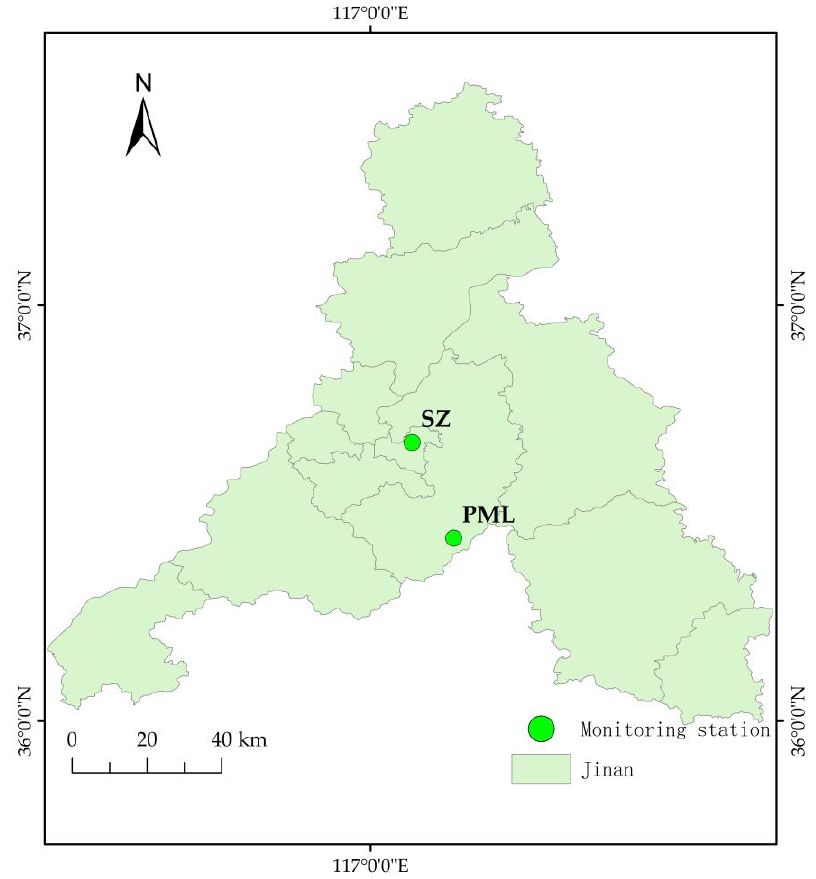
Figure 1. The geographical location of the two sites. SZ is the urban monitoring site and PML is the suburban site.